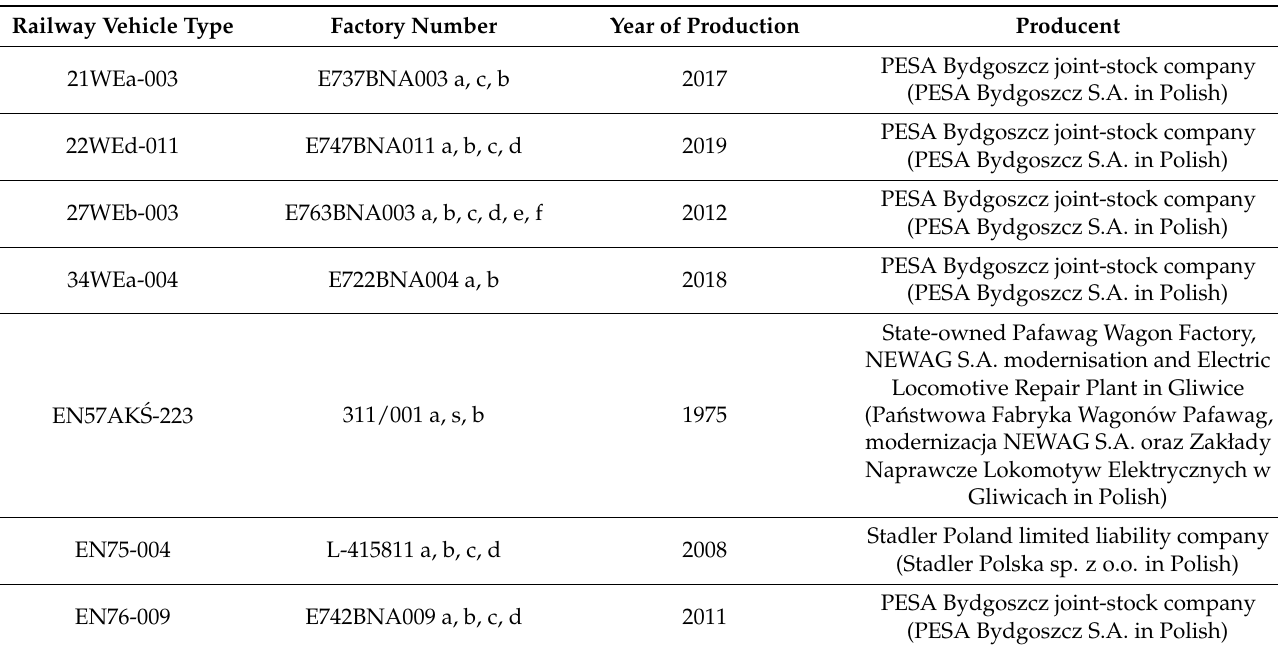
Table 2. List of railway vehicles subjected to